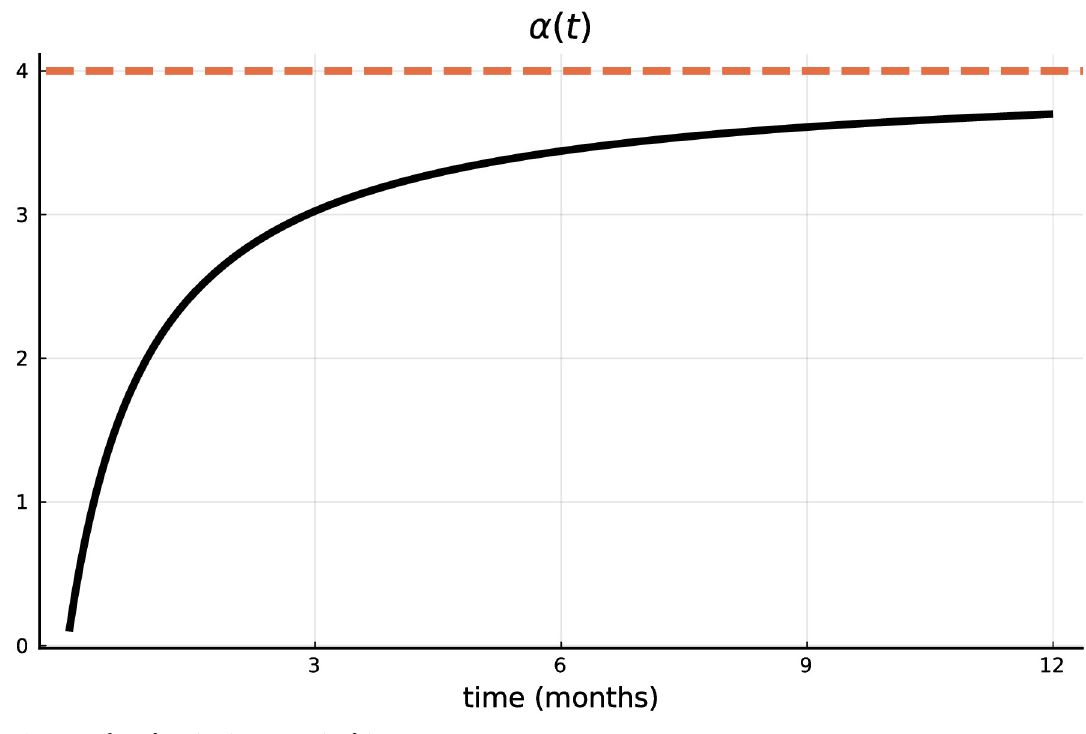
Fig 2. Number of vaccinations per unit of